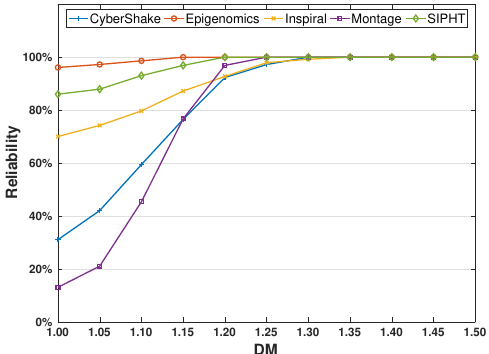
Figure 2. Reliabilities of workflows with the increasing deadline multiplier